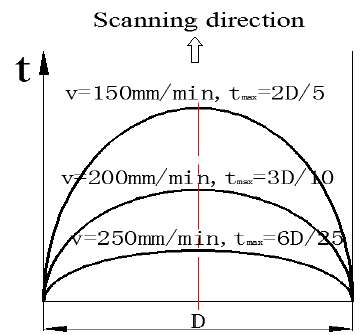
Figure 5. Heating time profiles at point P of coating surface vertical to the scanning direction.